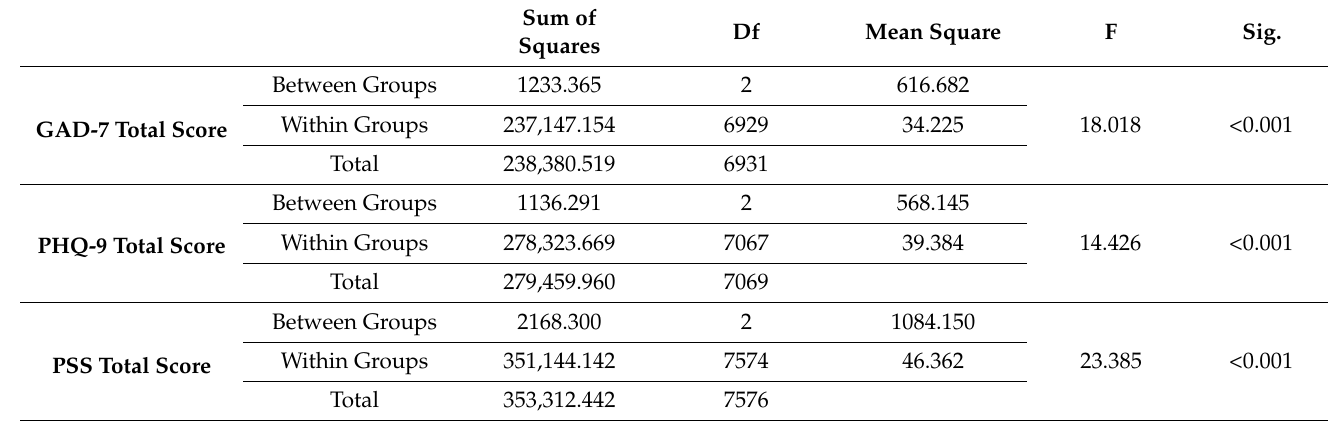
Table 4. One-way ANOVA comparing sums of squares between and within groups. Sum of Squares